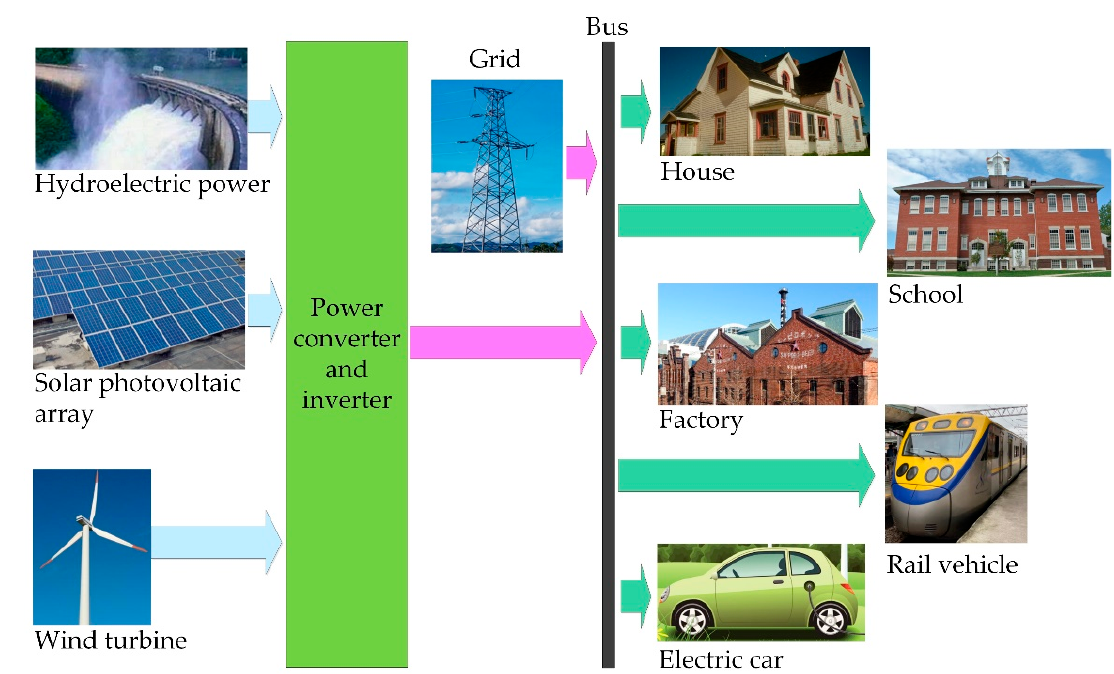
Figure 1. The schematic diagram of the grid with the renewable energy and the load demand.